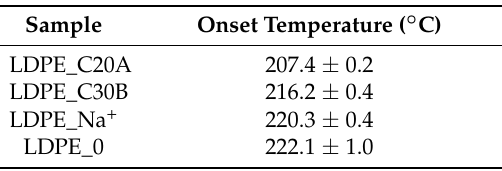
Figure 3. Weight loss measured by thermogravimetry due to the decomposition of the ADC in samples based on LDPE. Table 5. Onset temperature of ADC decomposition with the different types of nanoclays in the materials based on LDPE.